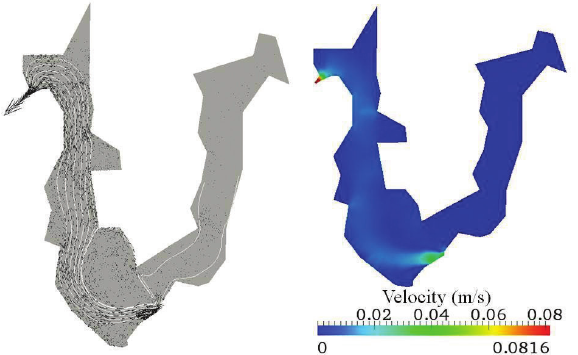
Figure 7 - Velocity field generated by Hydrosim hydrodynamic simulator, to the left, and its module.